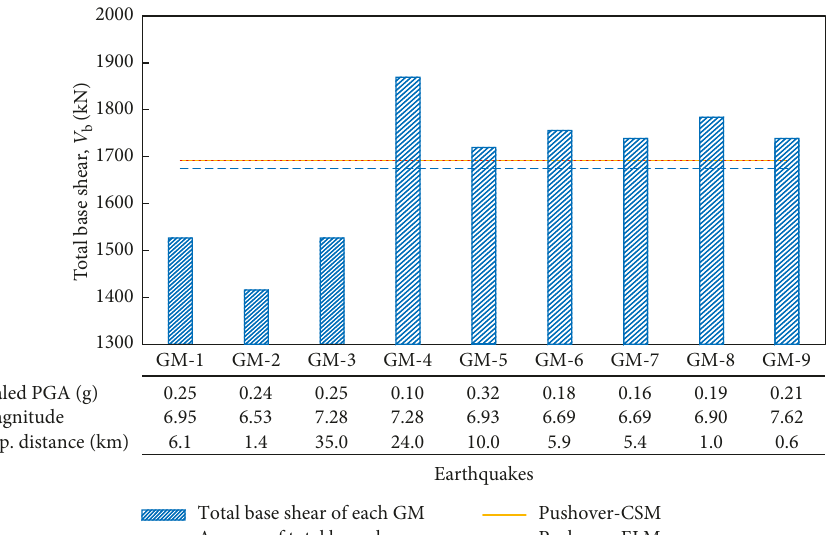
Figure 11: Total base shear versus earthquakes.